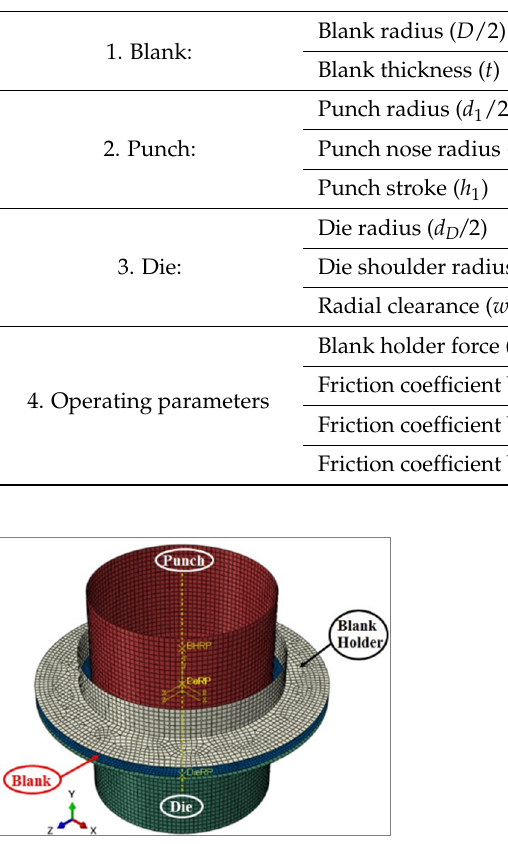
Figure 2. Assembly of the 3D finite element model (FEM) by ABAQUS.